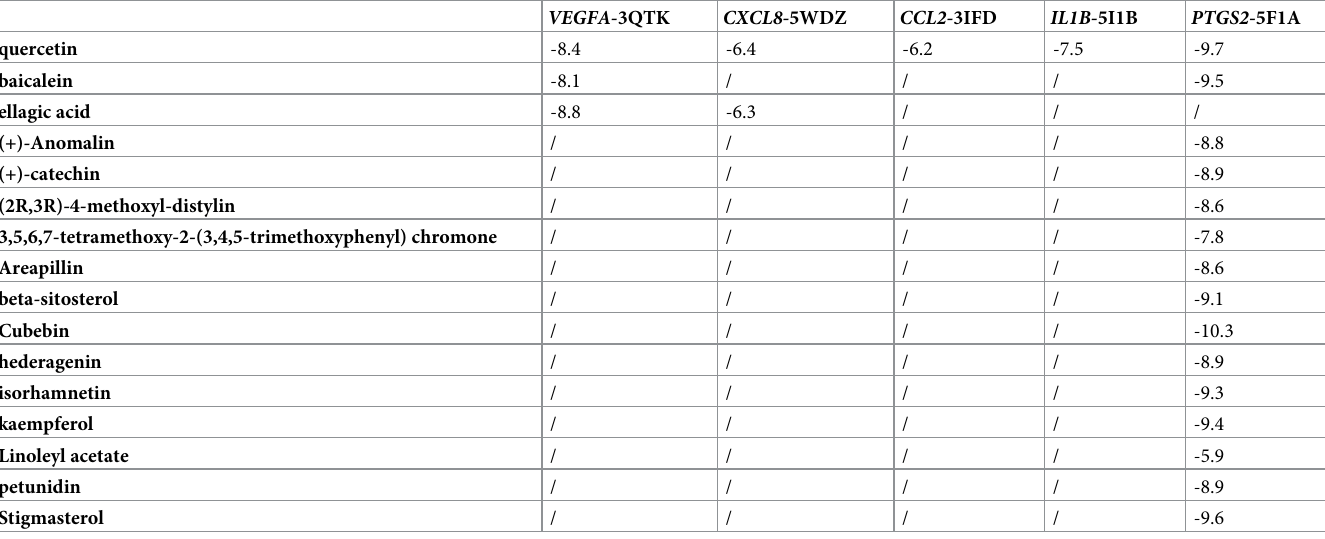
Table 4. The docking information of five target proteins with the corresponding